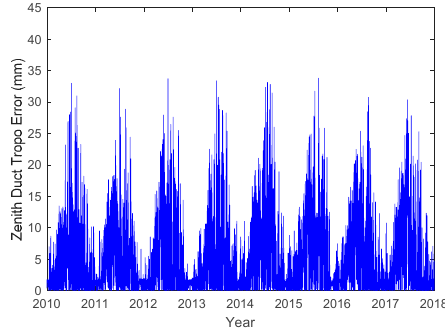
Figure 9. Zenith duct errors at the simulated location (120.3° E, 39.9° N).